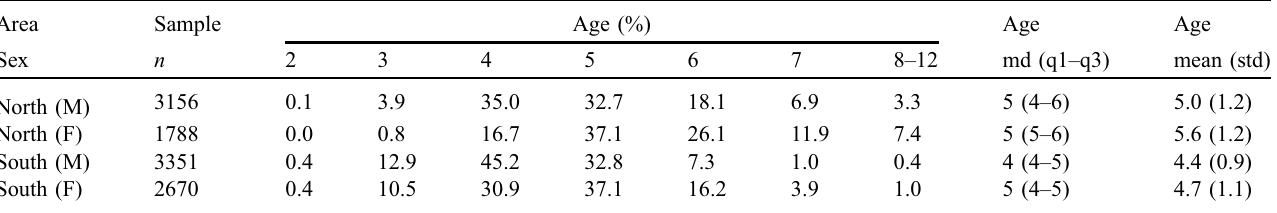
Number of fi sh= n . The P -value of the goodness-of- fi t test (Kolmogorov-Smirnov-test) for normal distribution for each four groups was P < 0.010.